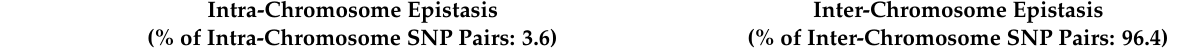
Table 1. Frequencies and statistical significance of intra- and inter-chromosome pairwise epistasis effects among the top 50,000 epistasis effects.